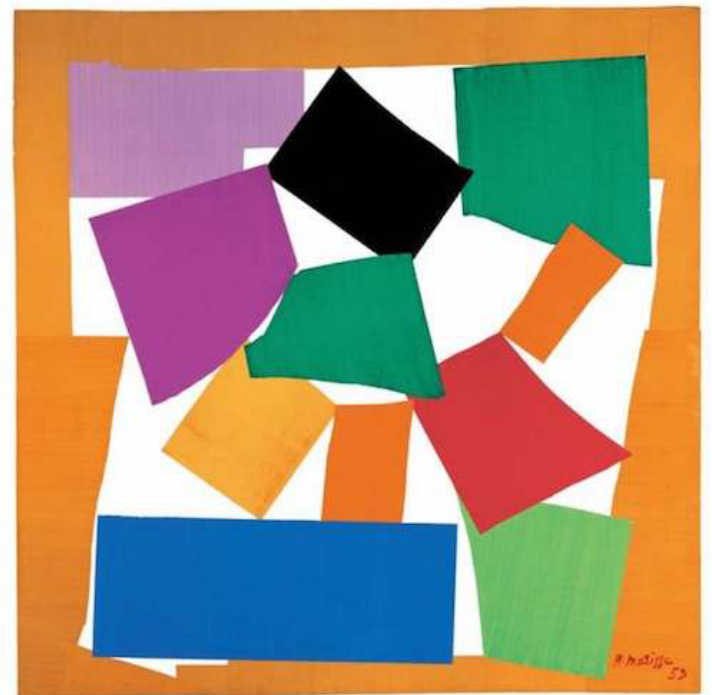
Source: http://www.independent.co.uk/arts-entertainment/art/reviews/henri-matisse-the-cut-outs-art-